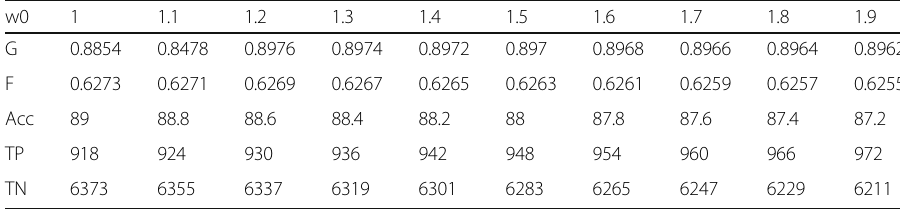
Table 6 DWSVM model w0 selection